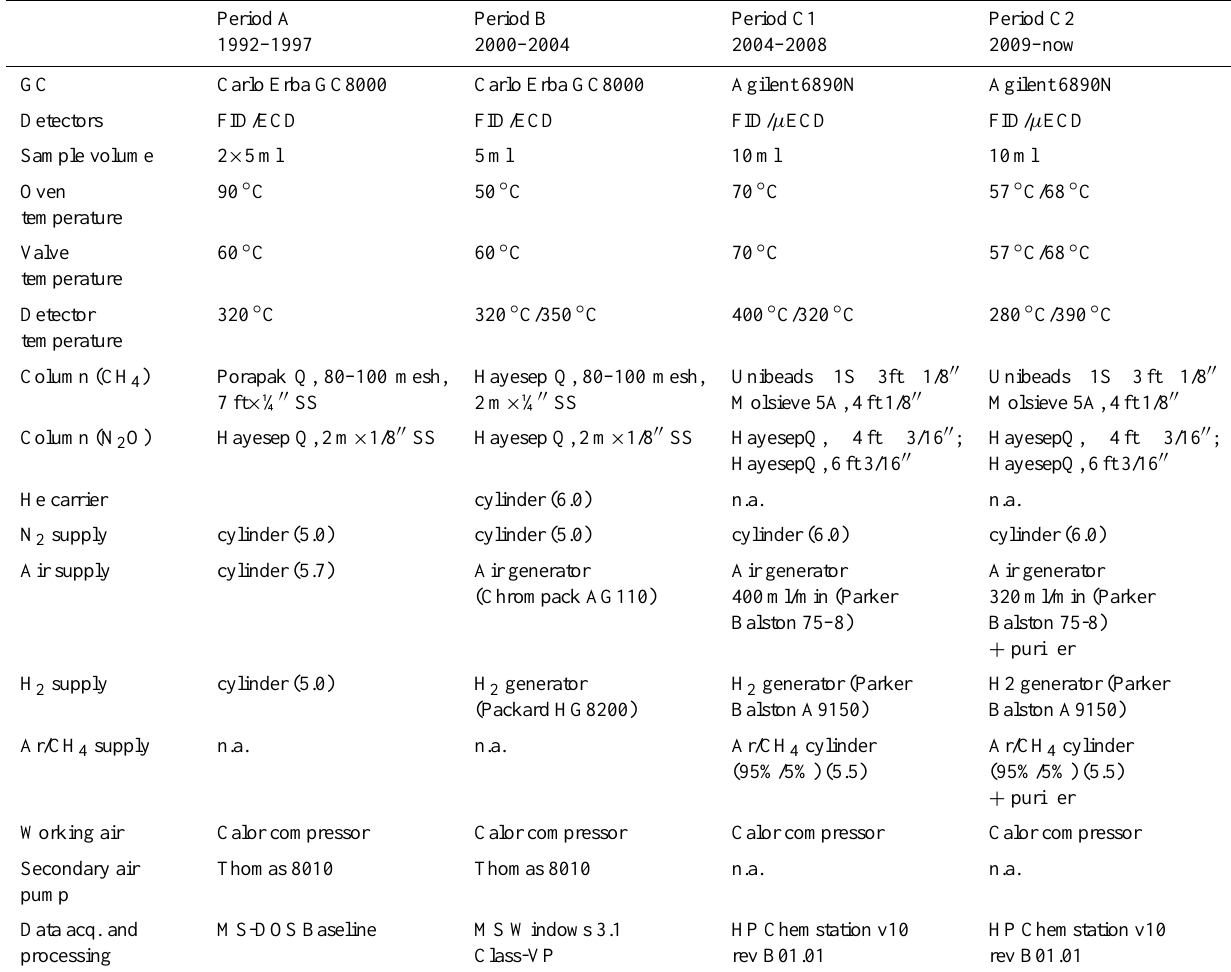
Table 1. Gas chromatographic equipment and setup at Cabauw for all